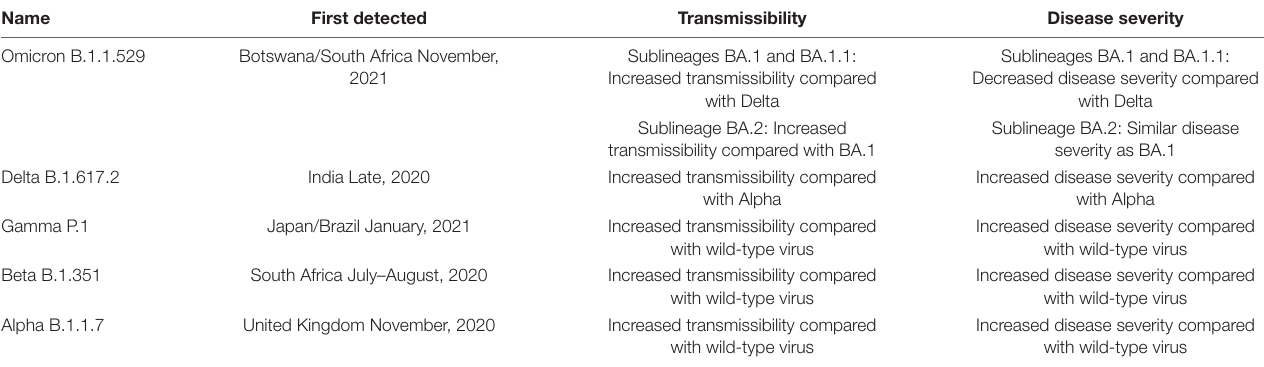
TABLE 2 | SARS-CoV-2 variants of concern (World Health Organization,